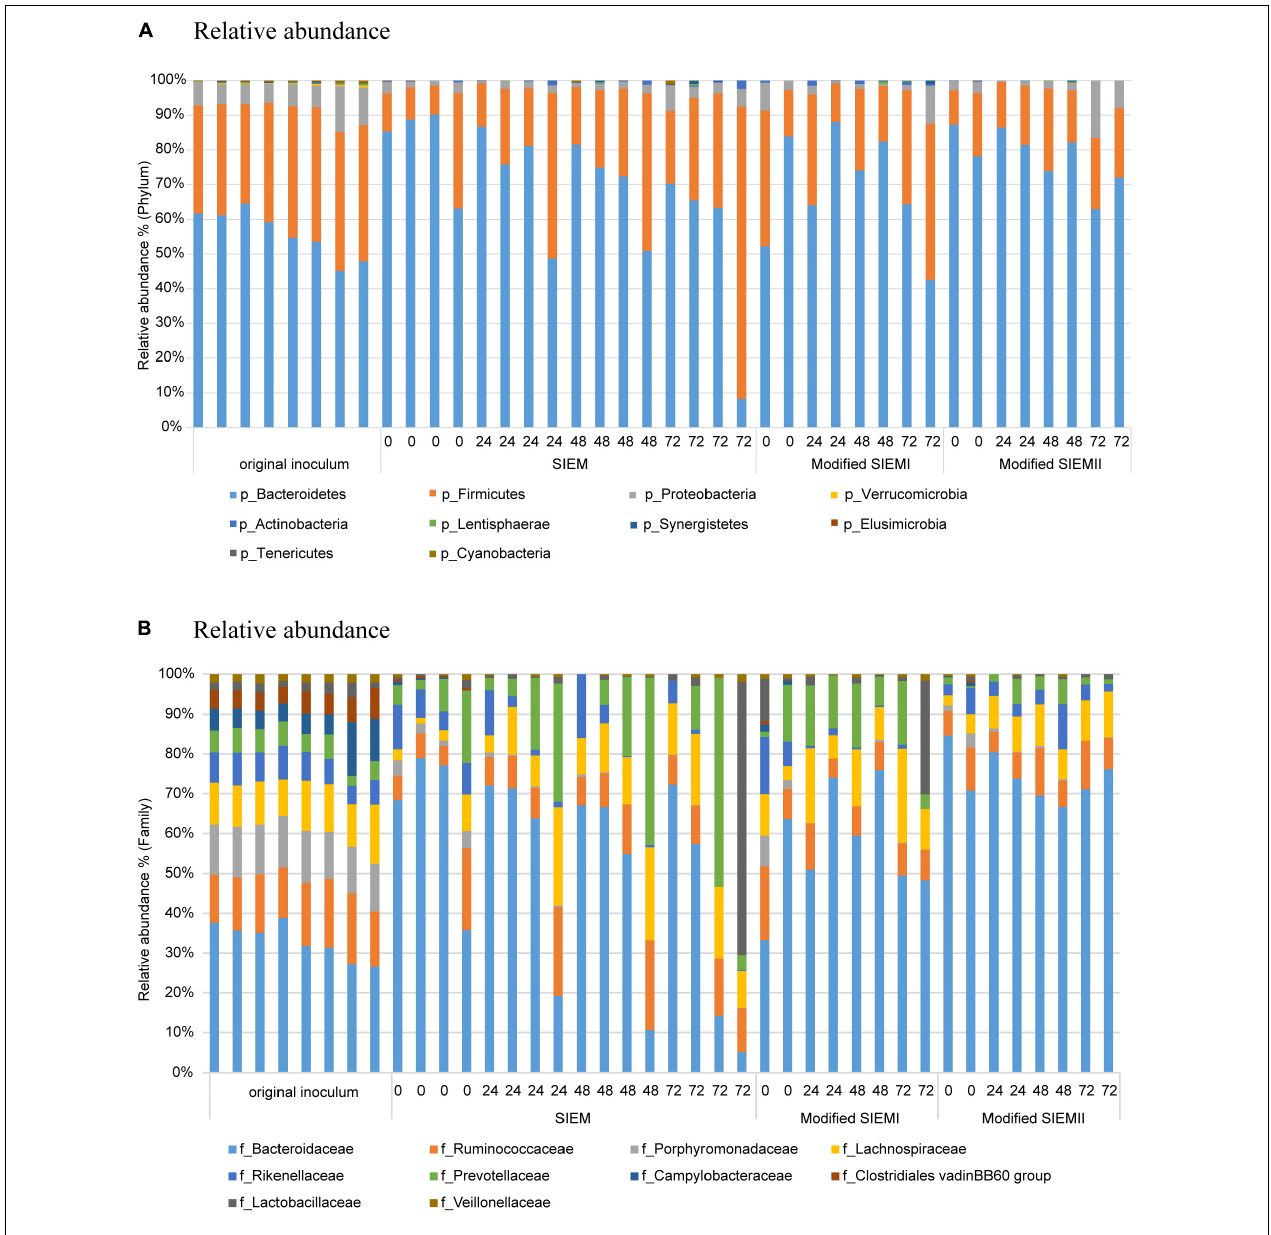
FIGURE 3 | Bacterial composition. Relative abundance of bacterial phyla (A) and families (B) in Chicken ALIMEntary tRact mOdel-2 samples using different feeding type at different time points compared to the original